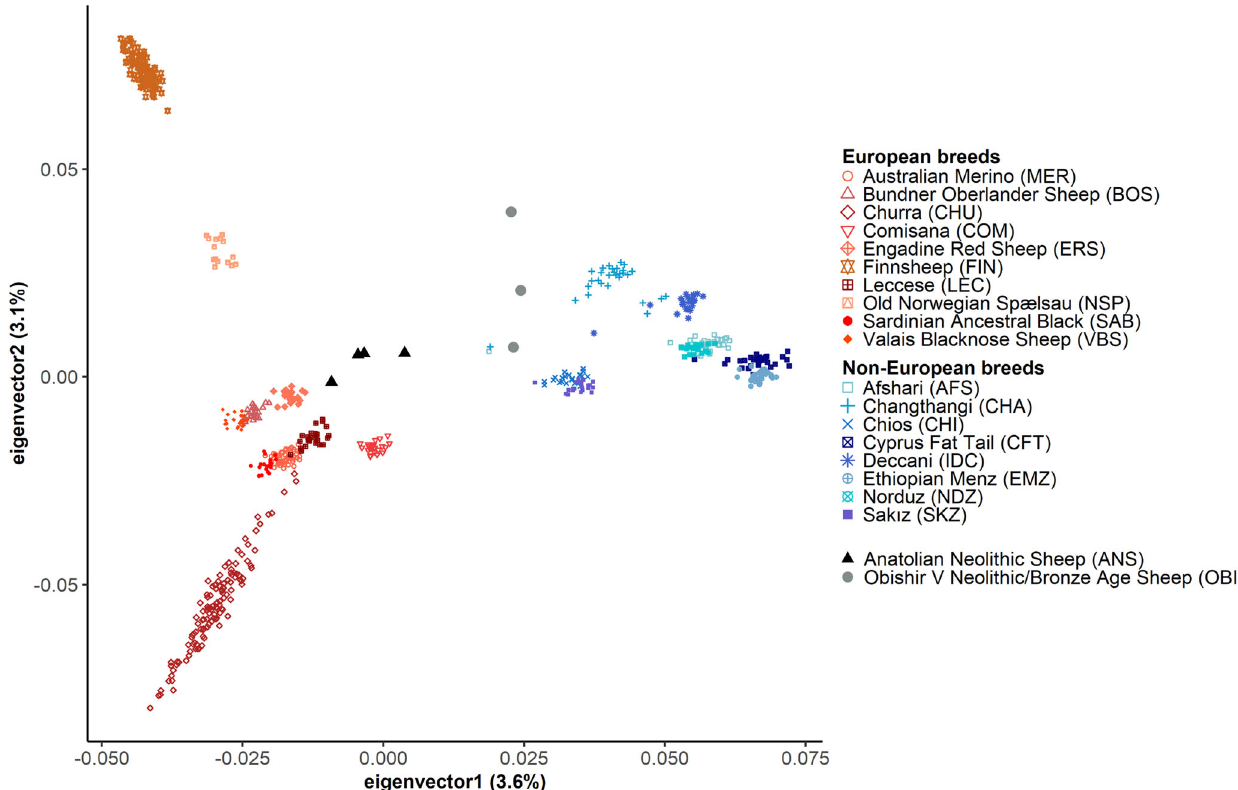
Fig. 2 Genomic variation of modern breeds, Anatolian Neolithic (ANS) and Obishir V (OBI) sheep. The graph represents the fi rst two components of a PCA calculated using genotypes of 18 modern sheep breeds ( n = 643). The four Anatolian Neolithic sheep individuals ’ genotypes (black triangles) and three Obishir V sheep individuals ’ genotypes (gray circles) were projected on these two components. Parentheses indicate the proportion of variance explained by the relevant